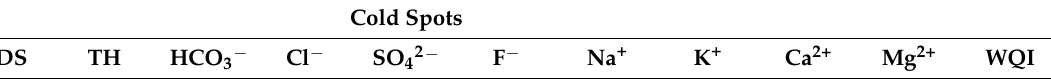
Table 3. Spearman correlation coefficient matrix of the groundwater quality parameters: (a) cold spots, (b) hotspots (strong correlations (r ≥ 0.75) are shown in bold). Cold Spots